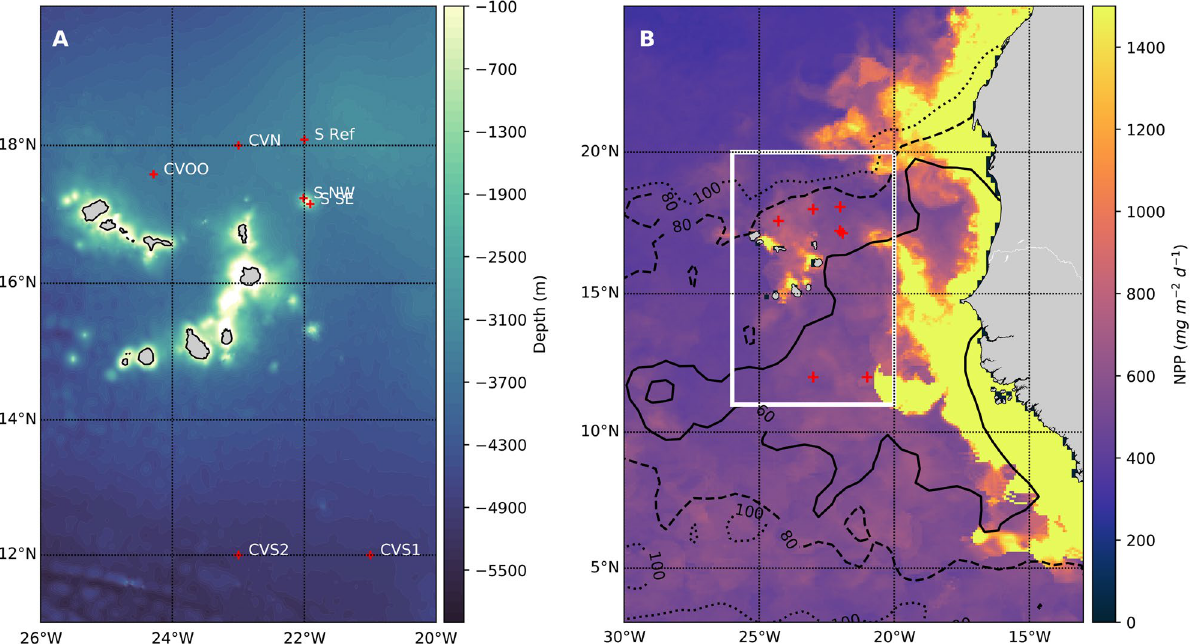
Figure 1. The eastern tropical North Atlantic ( A ). Zoomed-in working area, as in the white box from ( B ), around Cape Verde with coded stations indicated (color scale indicates GEBCO bathymetry). CVOO Cape Verde Ocean Observatory, CVN Cape Verde North, S Ref Senghor Reference, S NW Senghor North West, SSE Senghor South East, CVS1 Cape Verde South 1, CVS2, Cape Verde South 2. ( B ). with color scale indicating satellite-derived net primary productivity (NPP) during cruise MSM49 (estimated according to 51 and obtained from http://sites .scien ce.orego nstat e.edu/ocean .produ ctivi ty), black contours indicating 60, 80 and 100 µmol kg −1 oxygen at 400 m depth (World Ocean Atlas 2018). Red crosses indicate working stations. Maps were produced using python (packages: matplotlib and